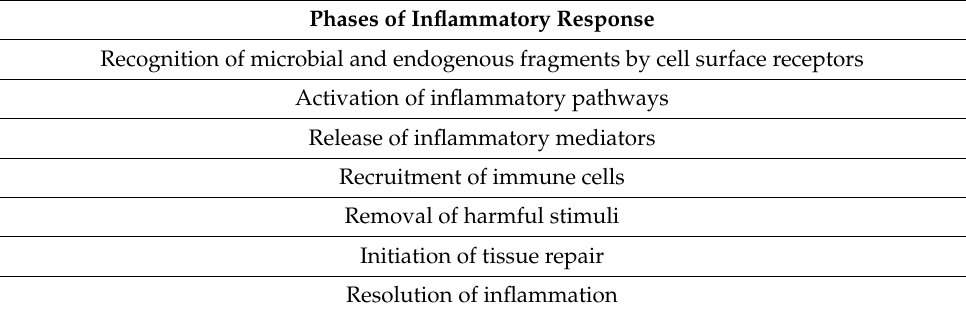
Table 3. Classical division of sequential steps of the inflammation